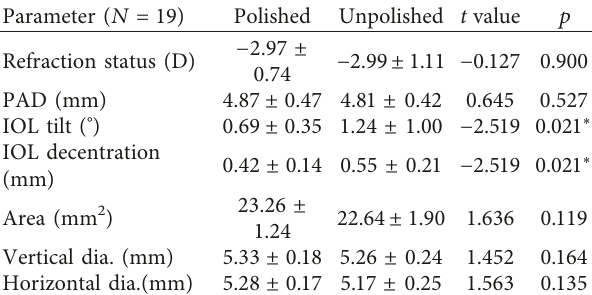
Table 4: Cross-sectional comparison between polished and un- polished groups at the 6 months after